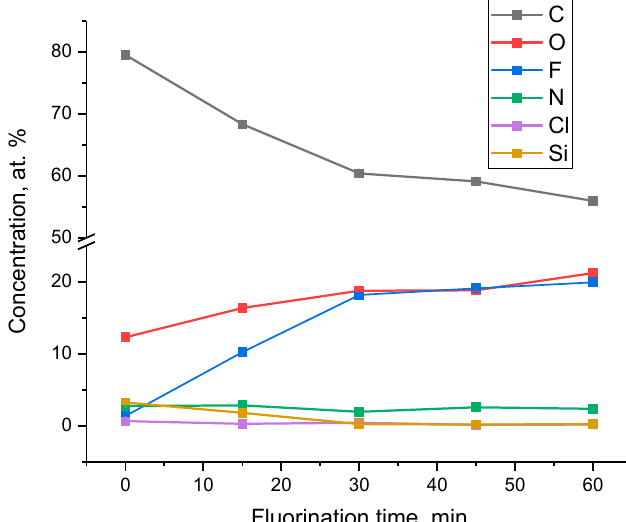
Figure 7. Change in the concentration of elements for surface of PIM-1 samples determined by XPS depending on the fluorination time.